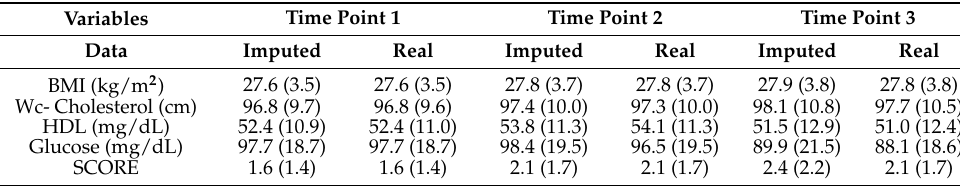
Table 1. Comparison between real and imputed data.